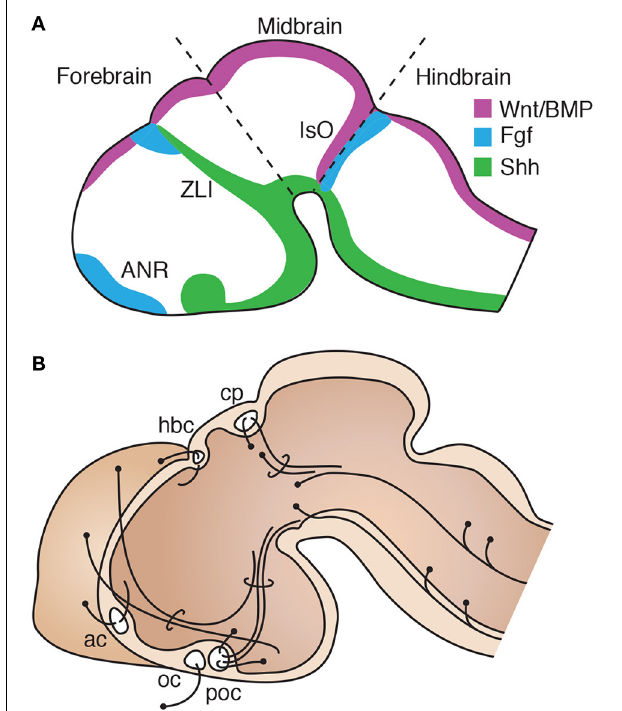
FIGURE 1 | Conservation of a general organization of vertebrate brain development. (A) Diagram of an early stage of brain development in a model vertebrate, equivalent to mouse E11, showing the principal regions of morphogen expression. Rostral expression of Fgf defines the anterior neural ridge (ANR). The zona limitans intrathalamica (ZLI) is defined by a narrow band of Shh expression, with Fgf and BMP/Wnt coexpression dorsally at the border between the presumptive telencephalon and diencephalon. Caudally, the isthmic organizer (IsO) marks the boundary between the midbrain and hindbrain territories. (B) Midsagittal schematic of a model vertebrate brain at a later stage, equivalent to mouse E14, showing the position of the first axon bundles that form during development, including the posterior commissure (cp) and post-optic commissure (poc), followed by the anterior commissure (ac), habenular commissure (hbc) and optic chiasm (oc). Dorsal is to the top and rostral to the